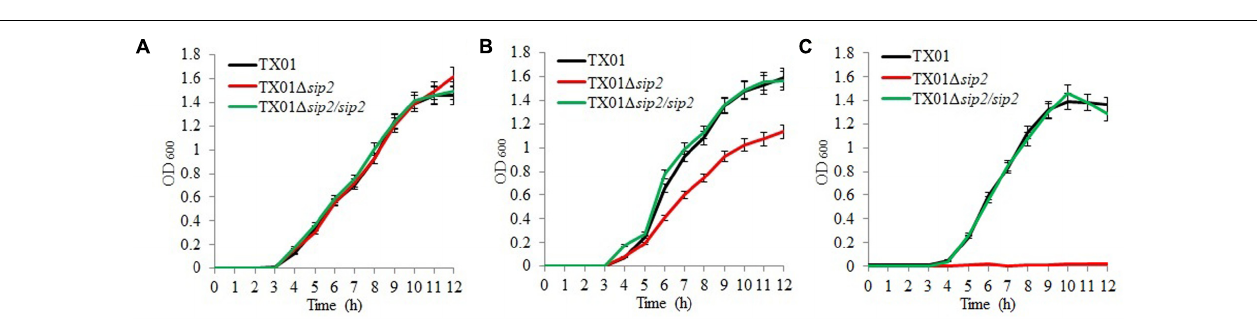
FIGURE 3 | Virulence of Edwardsiella tarda . (A) Tongue sole were inoculated with E. tarda TX01, TX01 (cid:49) sip2 , or TX01 (cid:49) sip2 / sip2 , and bacterial dissemination in kidney, spleen, and blood was determined by examining bacterial recoveries from the tissues at different time points. Data are the means of three independent assays and presented as means ± SEM. ∗∗ P < 0.01, ∗ P < 0.05. (B) Tongue sole were infected with E. tarda as above, and mortality of the fish was calculated at different time points. (C) Tongue sole peripheral blood leukocytes (PBL) were infected with TX01, TX01 (cid:49) sip2 , or TX01 (cid:49) sip2 / sip2 for 1 h, and extracellular bacteria were killed; intracellular bacterial number was determined at different time points. Data are the means of three independent assays and presented as means ± SEM.